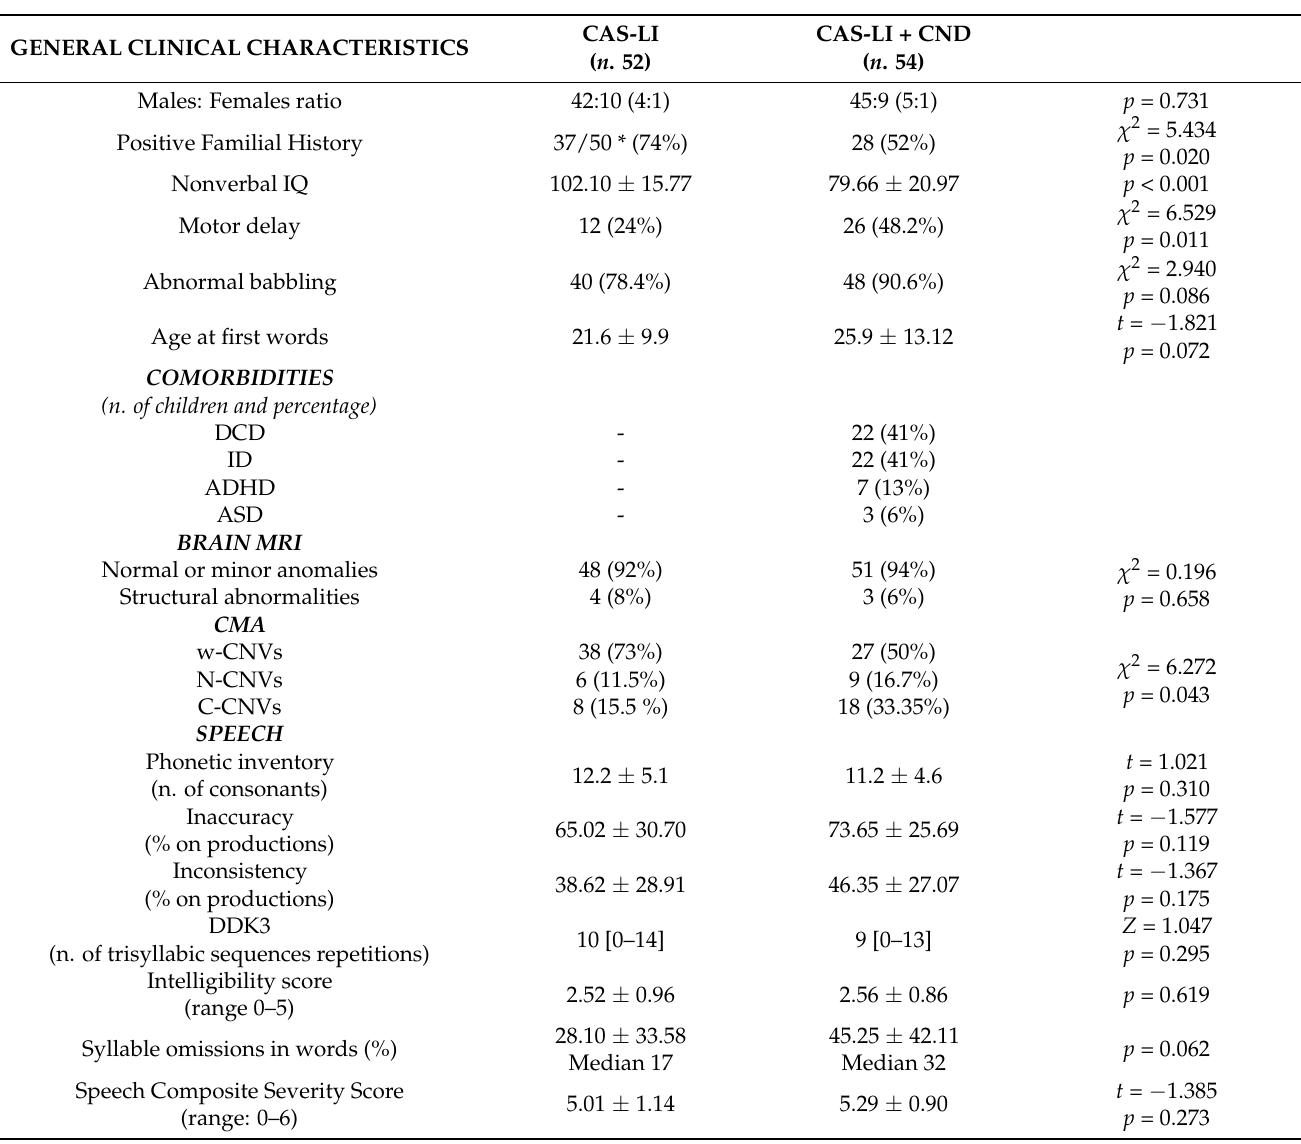
Table 1. Comparisons between CAS-LI and CAS-LI +